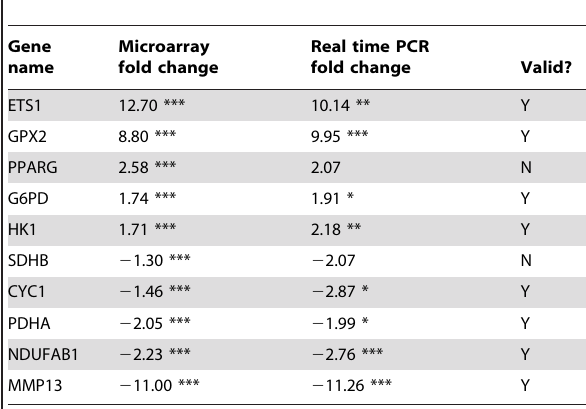
Table 1. Real time qRT-PCR validation of microarray